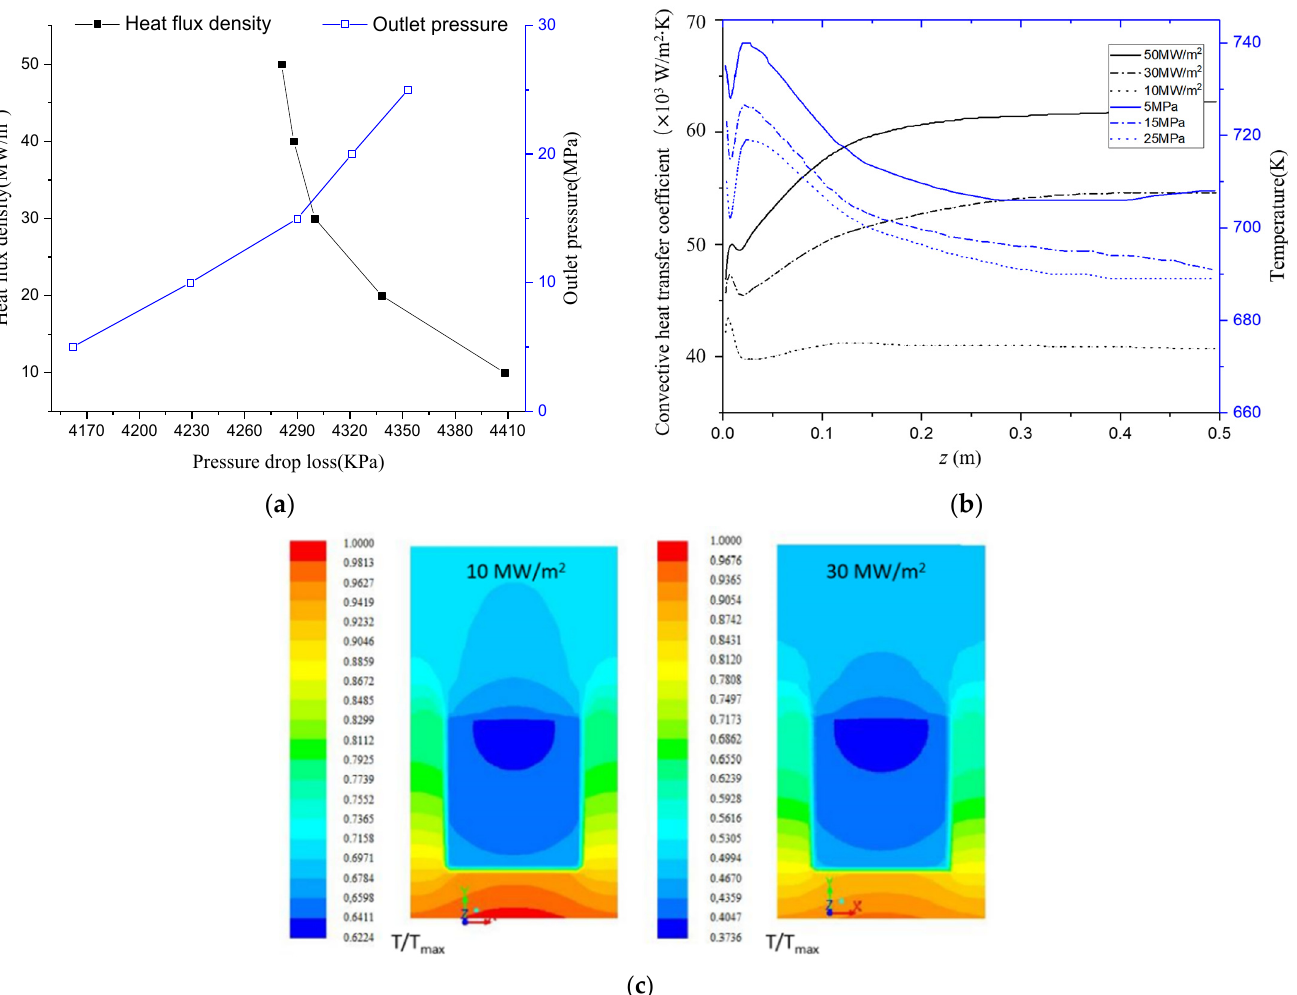
Figure 5. Effects of heat flux density on ( a ) pressure drop loss, ( b ) convective heat transfer coefficient at the center line, and ( c ) contours of normalized temperature at z = 250 mm.